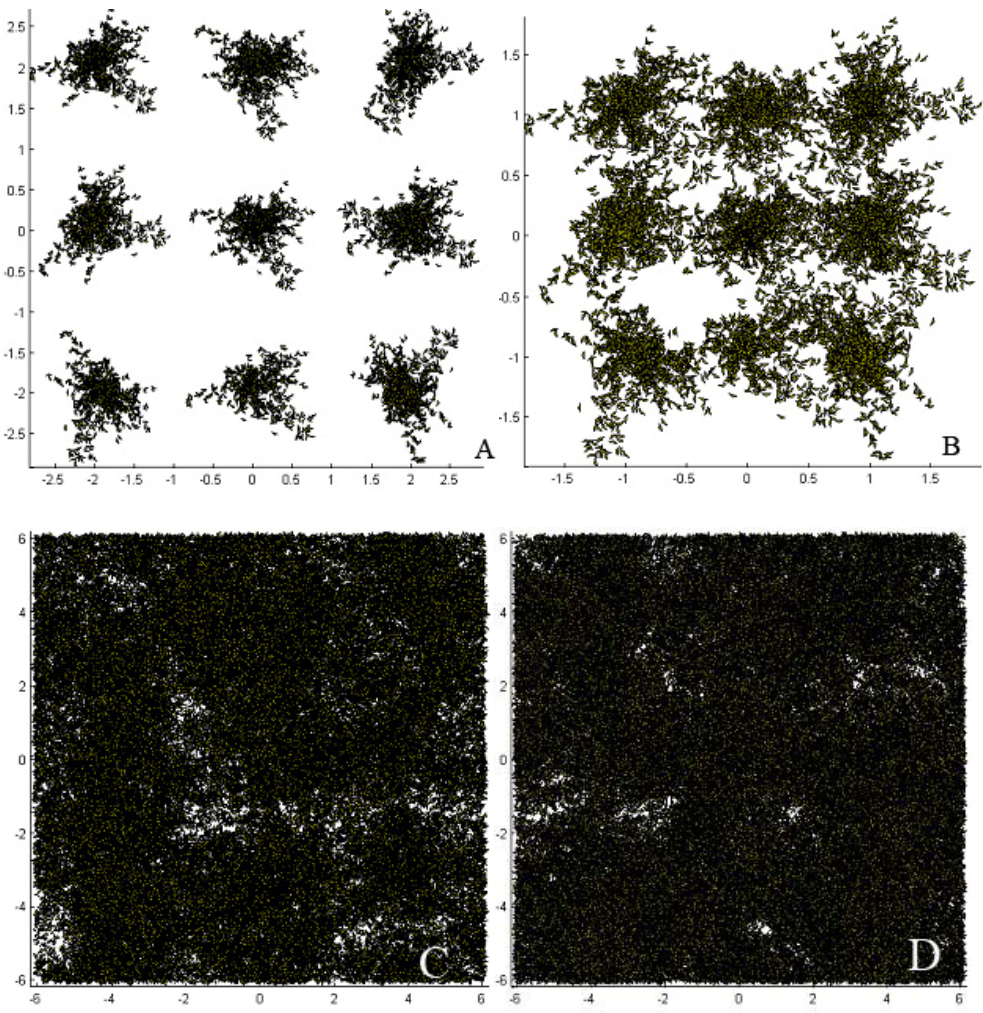
Figure 2. Simulated Fagus sylvatica (L.) stand comprised of 9 trees. Four LAI scenarios are presented. Upper stands (9 years old Fagus) are derived from in situ measured trees; (A) with the observed plantation distance of 1.8 m × 2.0 m (LAI = 0.58), and (B) with a changed plantation distance of 1.0 m × 1.0 m (LAI = 1.29). Bottom stands (15 years old Fagus) are derived from AMAP library and have an LAI of 2.76 (C) and 3.65 (D) respectively. The axes of the figures indicate the stand dimensions in